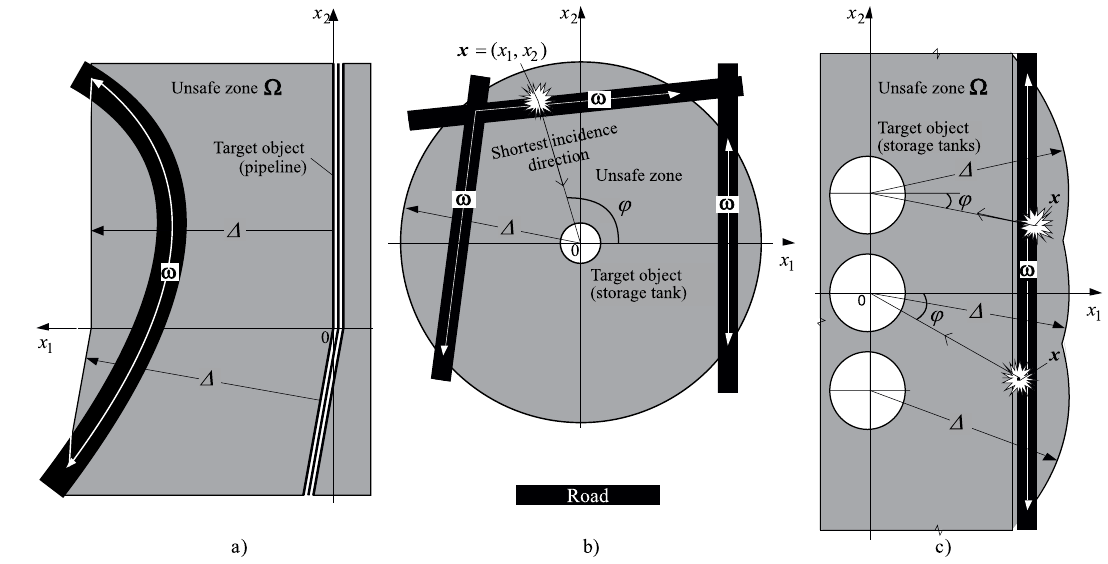
Fig. 1. Safety distance , unsafe zone and unsafe road segment at different configurations of the target object: a – above-ground pipeline or other energy supply line; b – circular storage tank; c – storage tanks arranged in a